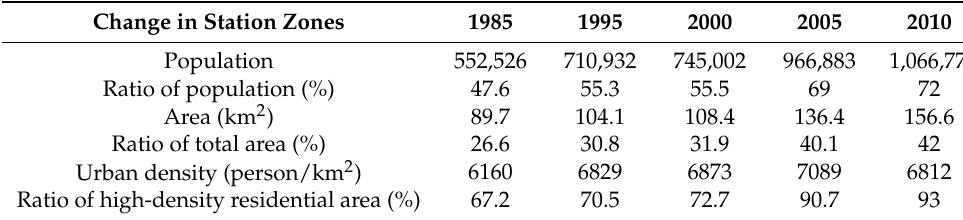
Table 3. Changes in station zone acreage and population.